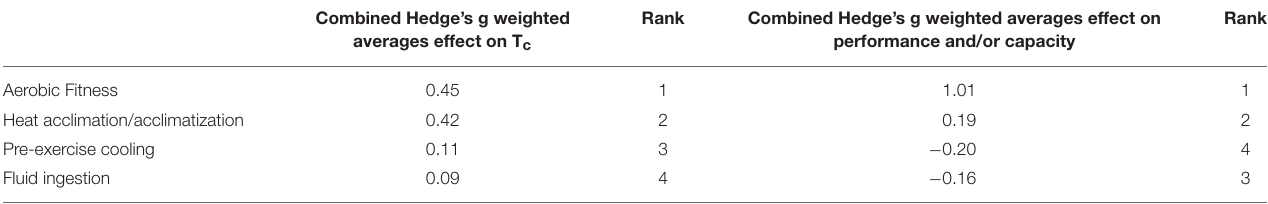
TABLE 5 | Ranking of heat mitigation strategies based on Hedges’ g weighted